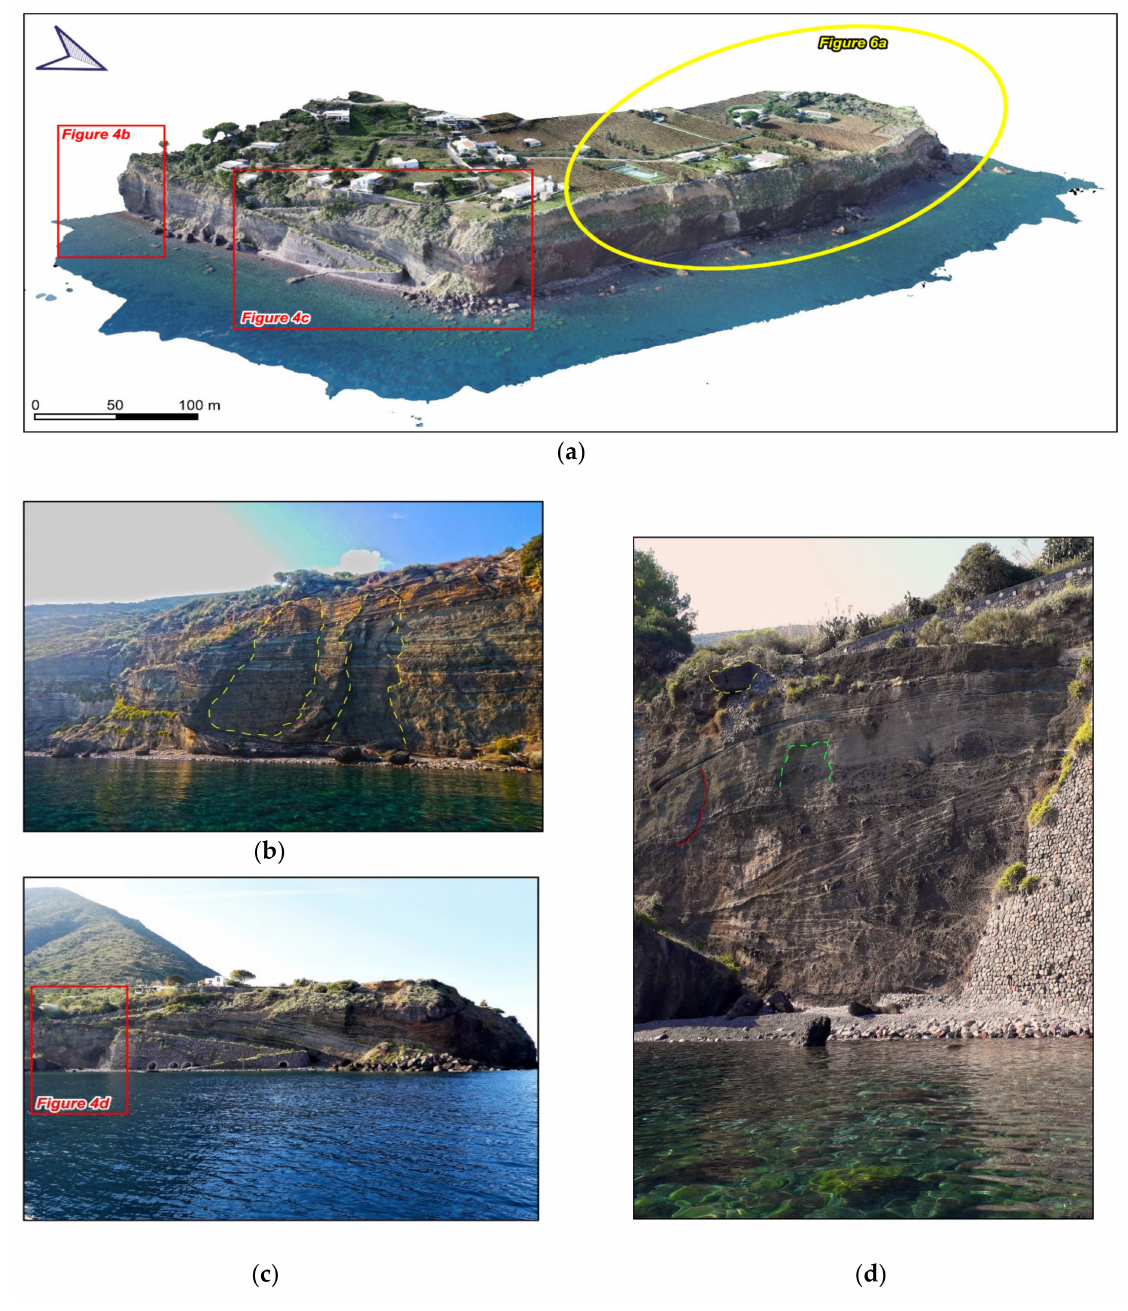
Figure 4. ( a ) The 3D model, generated after dense point cloud extraction by UAV photogrammetric flight through Agisoft Metashape, shows the flat area on which vineyards and buildings are located. It is bounded by an unstable coastal cliff with gravitational phenomena threatening the pocket beaches. ( b , c ) shooting areas are indicated by red squares; the yellow circle shows the zoomed 3D of Figure 6a; ( b ) Two large detachment surfaces and cavities of recent rockfalls characterising the cliff in question. The boulders in the foreground have an estimated size (through the dense point cloud) of about 1000 m 3 ; ( c ) The eastern part of the sea cliff from the boat shows the impressive rock avalanche with the subsequent 30 m retreating at the tip of Capo Faro Promontory occurred in 2011. ( d ) shooting area is indicated by a red square; ( d ) A projecting big boulder (dashed yellow line) on the top of the scarp where a recent rockfall creates a detachment surface (dashed green line) parallel to the scarp. A red line indicates an open fracture in pyroclastic